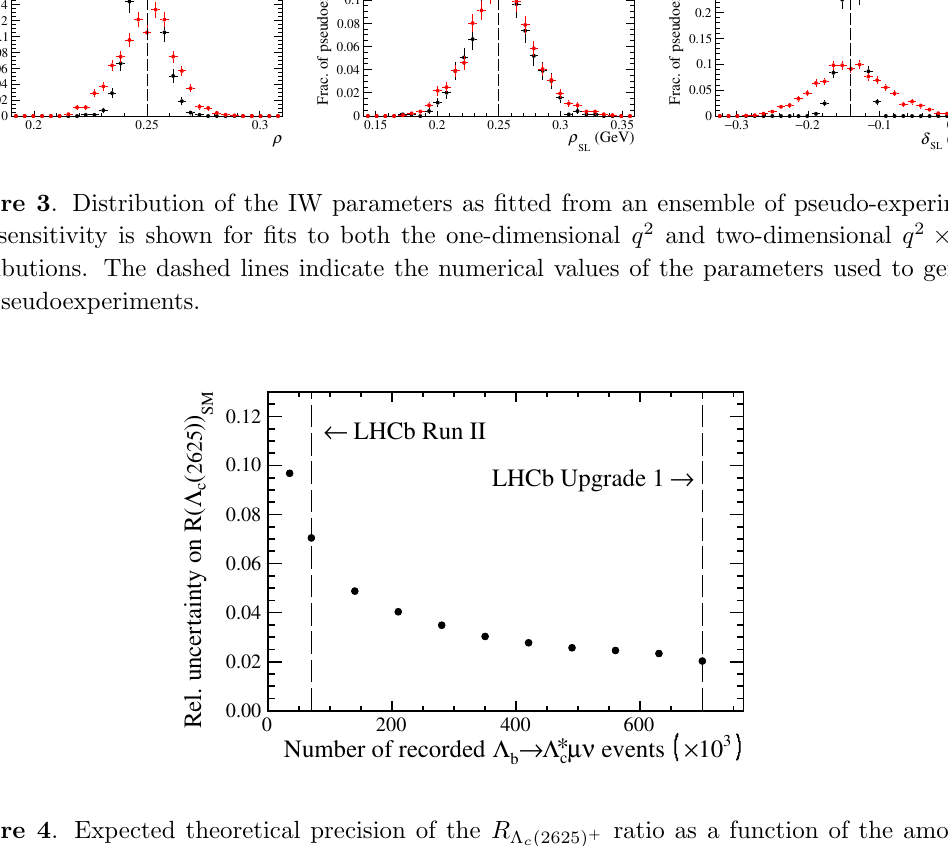
ratio as a function of the amount of (cid:3) c (2625) +